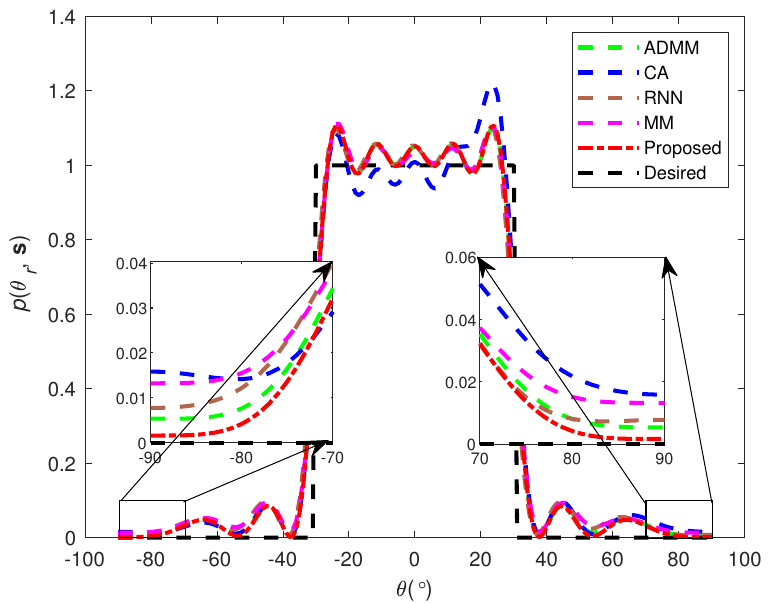
Figure 2. The beampattern matching comparison between different methods when considering Case 1 as the desired